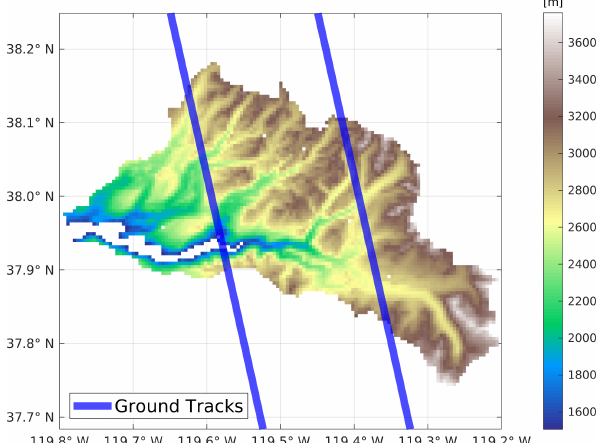
Figure 1. Elevation of the upper Tuolumne watershed (above Hetch Hetchy Reservoir). Blue lines are the synthetic ground tracks pass- ing through the study domain. The hypothetical tracks are about 1km wide and the distance between the two tracks is approximately